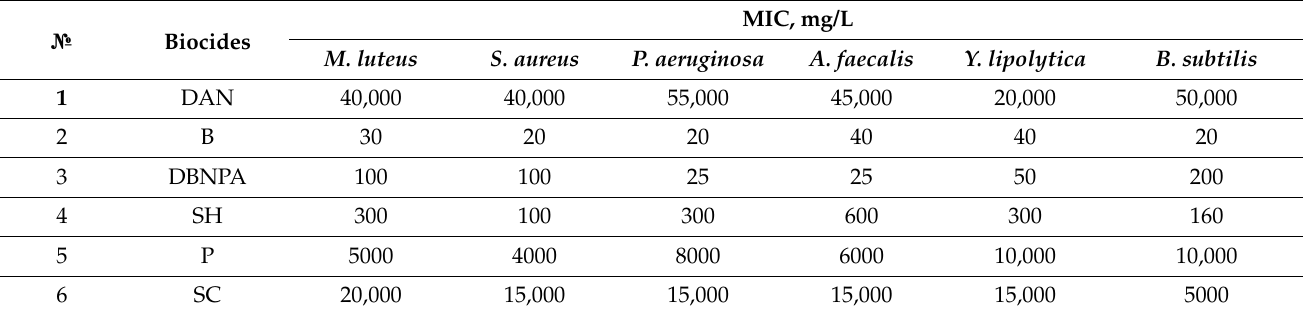
Table 1. MIC of the studied biocides for